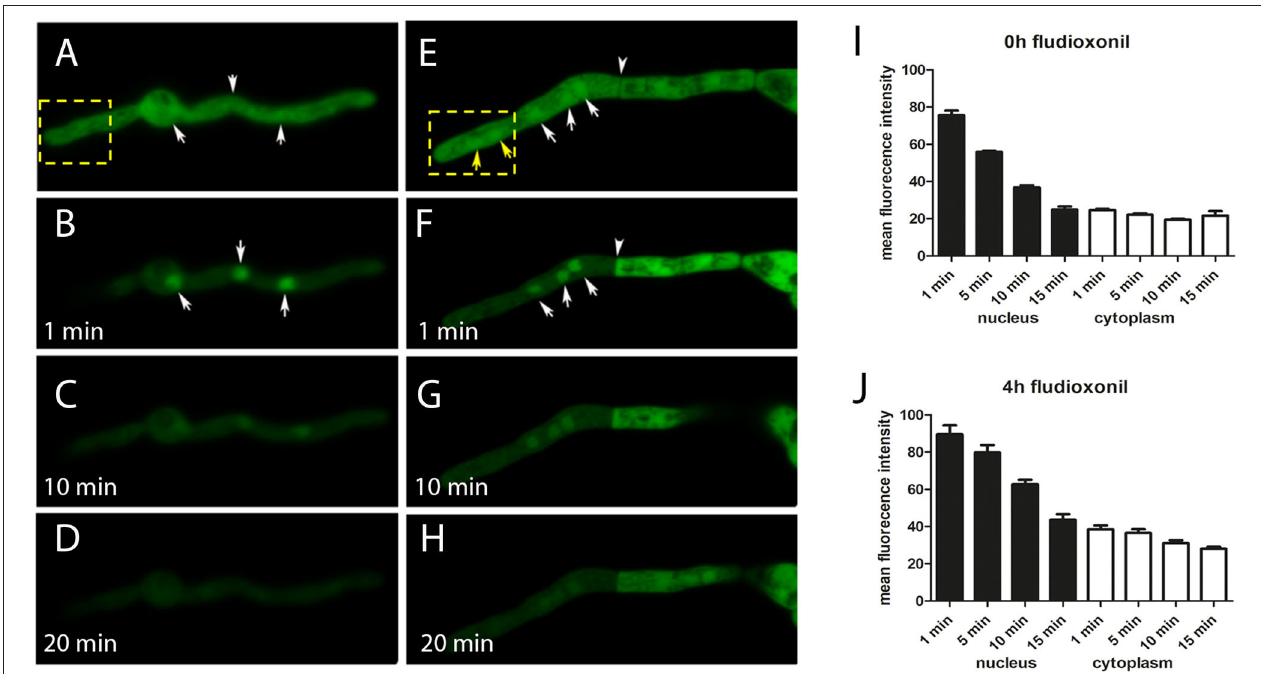
FIGURE 1 | Localization of GFP-Ypd1 in A. fumigatus . The spatial distribution of the fusion protein in normal hyphae of strain AfS35 and 4h after addition of 1 µ g/ml fludioxonil is shown in (A) and (E) , respectively. The depicted hyphae were then bleached (the corresponding areas are indicated by yellow boxes). This treatment let to a disappearance of the cytosolic GFP signals in the whole hypha or compartment, depending on the condition of the septal pore. Nuclei in this zone also lost their GFP fluorescence ( F , yellow arrows), but the GFP-signals in those nuclei that were not exposed to the bleaching were not affected ( A,B,E,F , white arrows). The relative enrichment of the GFP-signals in these nuclei disappeared over time (C / D and G / H) . The arrowhead in (F) points to a septum that was closed in response to fludioxonil. (A–H) Show single optical planes of confocal images. (I,J) Show a quantification of GFP fluorescence in nuclei (closed bars) and cytoplasm (open bars) of control hyphae (I) and hyphae treated with fludioxonil for 4 h (J)